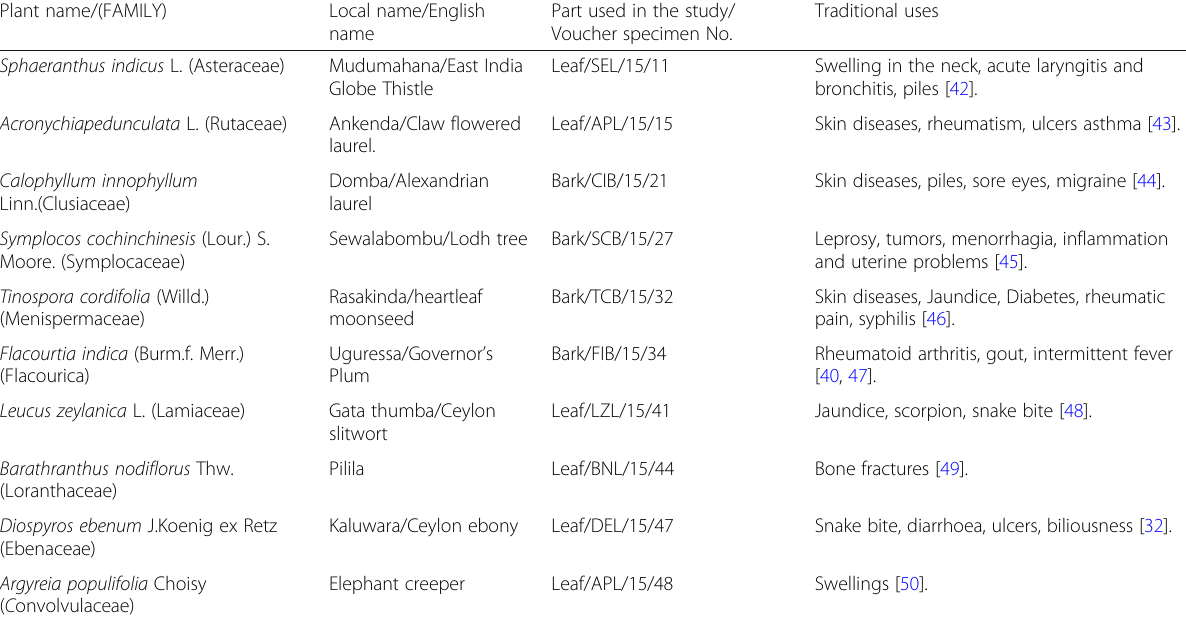
Table 1 Traditional uses of ten Sri Lankan medicinal